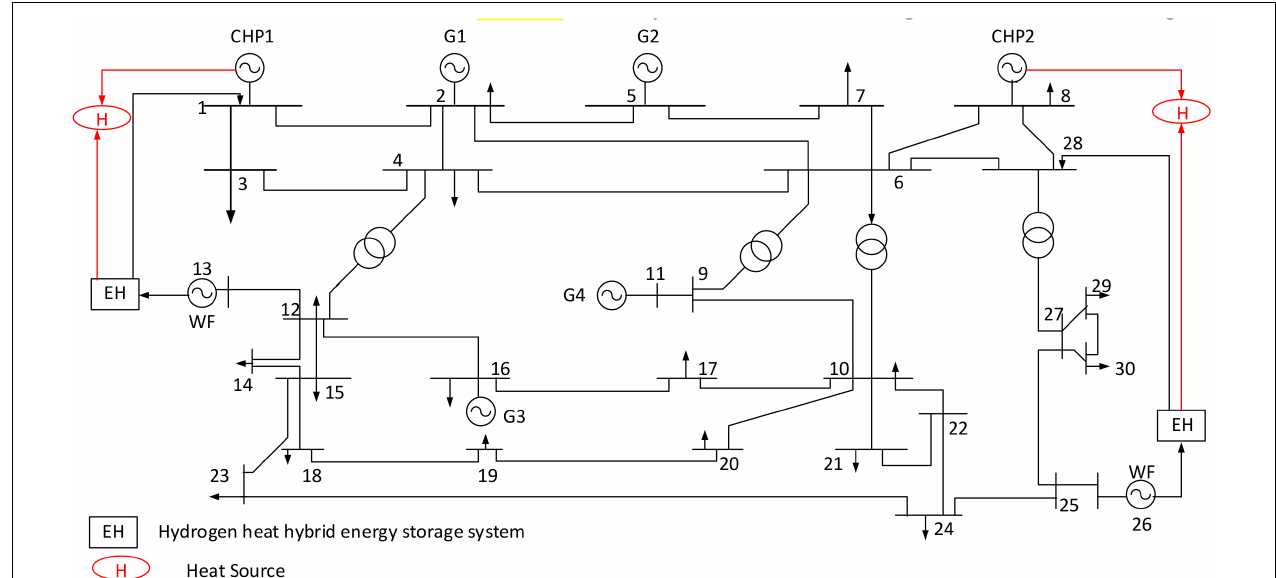
FIGURE 8 | System structure topology diagram.